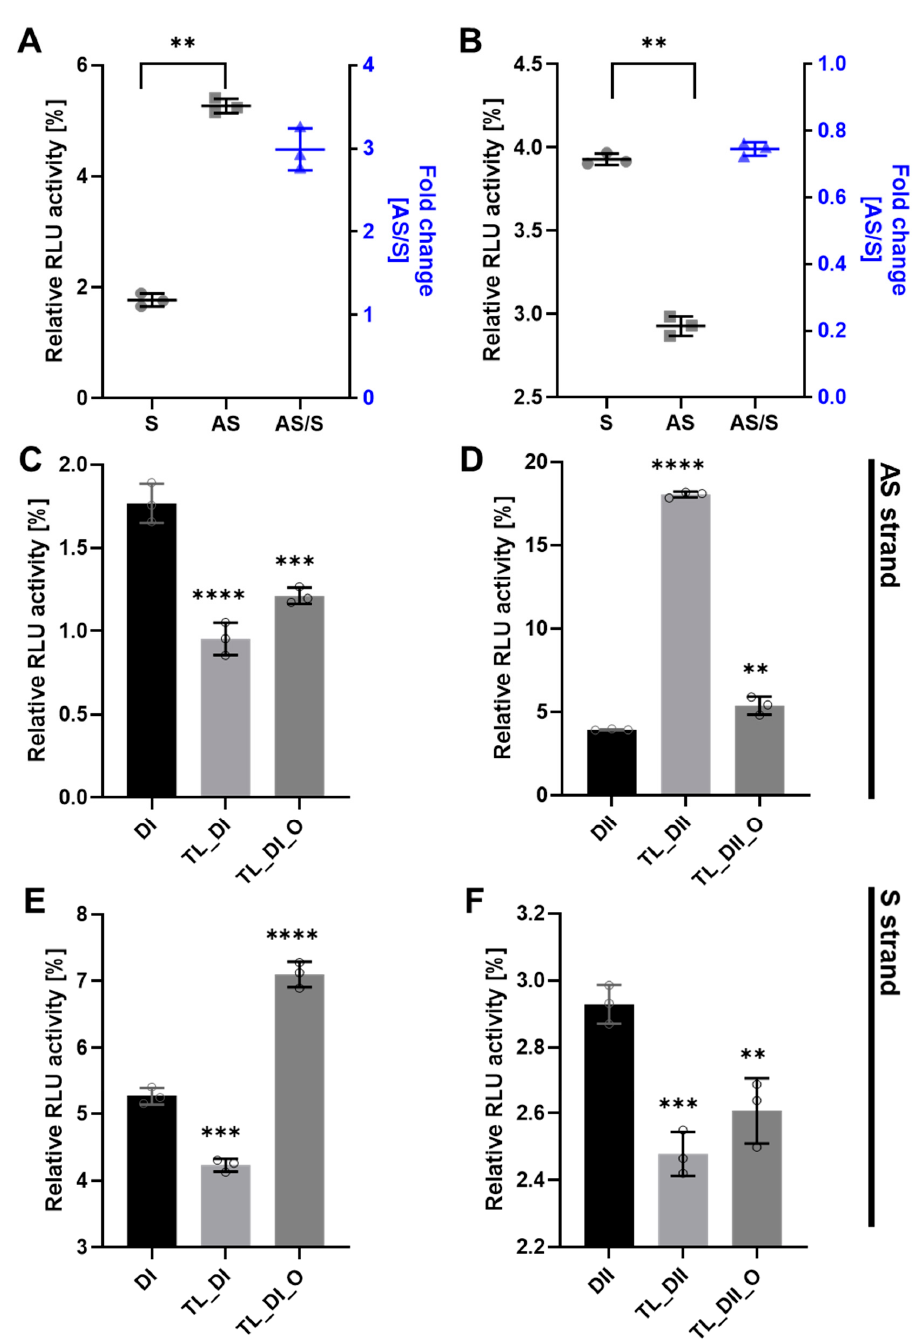
Figure 6. DsiRNA efficacy in HCT116 cells. Humanized Renilla luciferase was cloned in either the sense or antisense orientation into hnRNPH1 transcripts to act as a reporter. Relative expression of Renilla luciferase was determined by dual-luciferase assay against an internal control of firefly lu- ciferase; Renilla activities were normalized to those of firefly and arbitrarily set at 100. Data represent the mean ± S.D. from three independent experiments (Student’s t -test ** p < 0.01, *** p < 0.001, and **** p < 0.0001). We transfected the dual-luciferase reporter (S reporter targeting the sense strand of DsiRNAs, AS reporter targeting the antisense strand of DsiRNAs) and variant DsiRNAs into HCT116 cells. The DsiRNAs represented are: ( A ). DsiRNA I, ( B ). DsiRNA II, ( C ): DsiRNA I_S, ( D ): DsiRNA II_S, ( E ): DsiRNA I_AS, and ( F ): DsiRNA